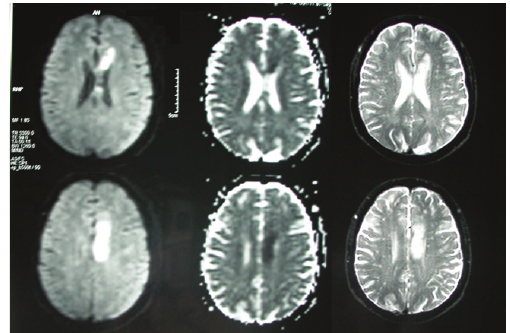
Figure 1: The first MRI shows an infarct in left centrum semiovale near the left lateral ventricle with mismatch in DWI and ADC map imaging and also multiple lacunar infarcts.